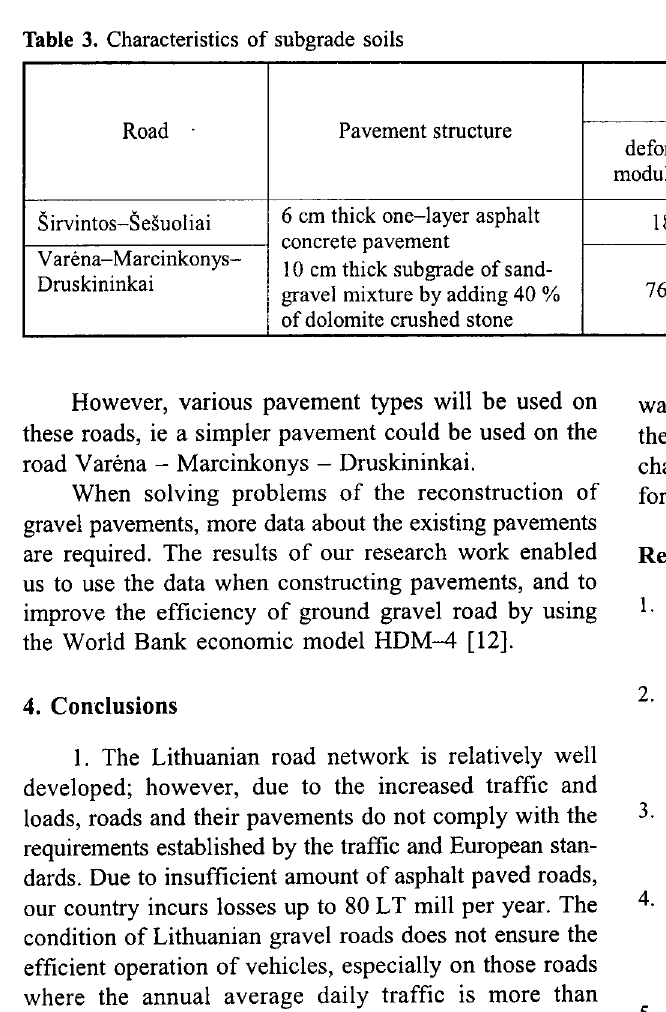
Table 3. Characteristics of subgrade soils